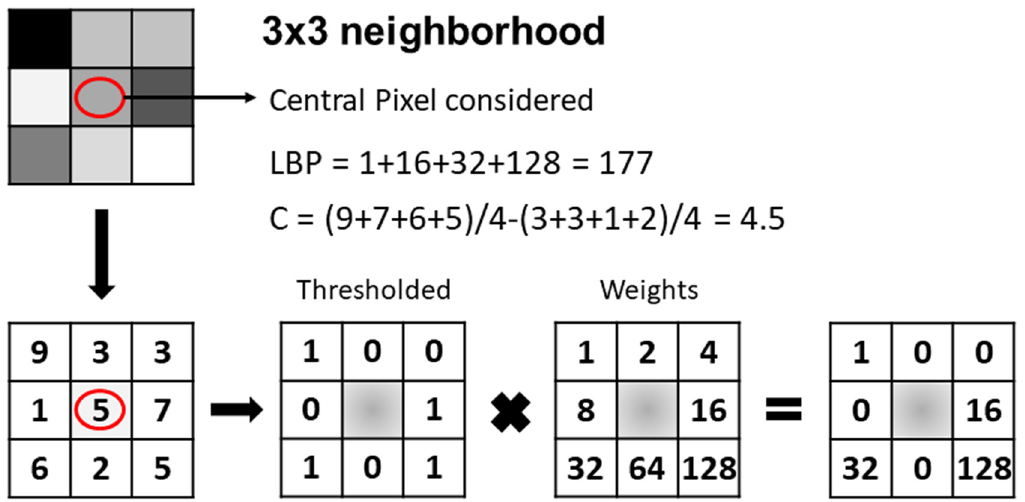
Figure 4. Computation of local binary patterns (LBP) and the contrast measure (C).